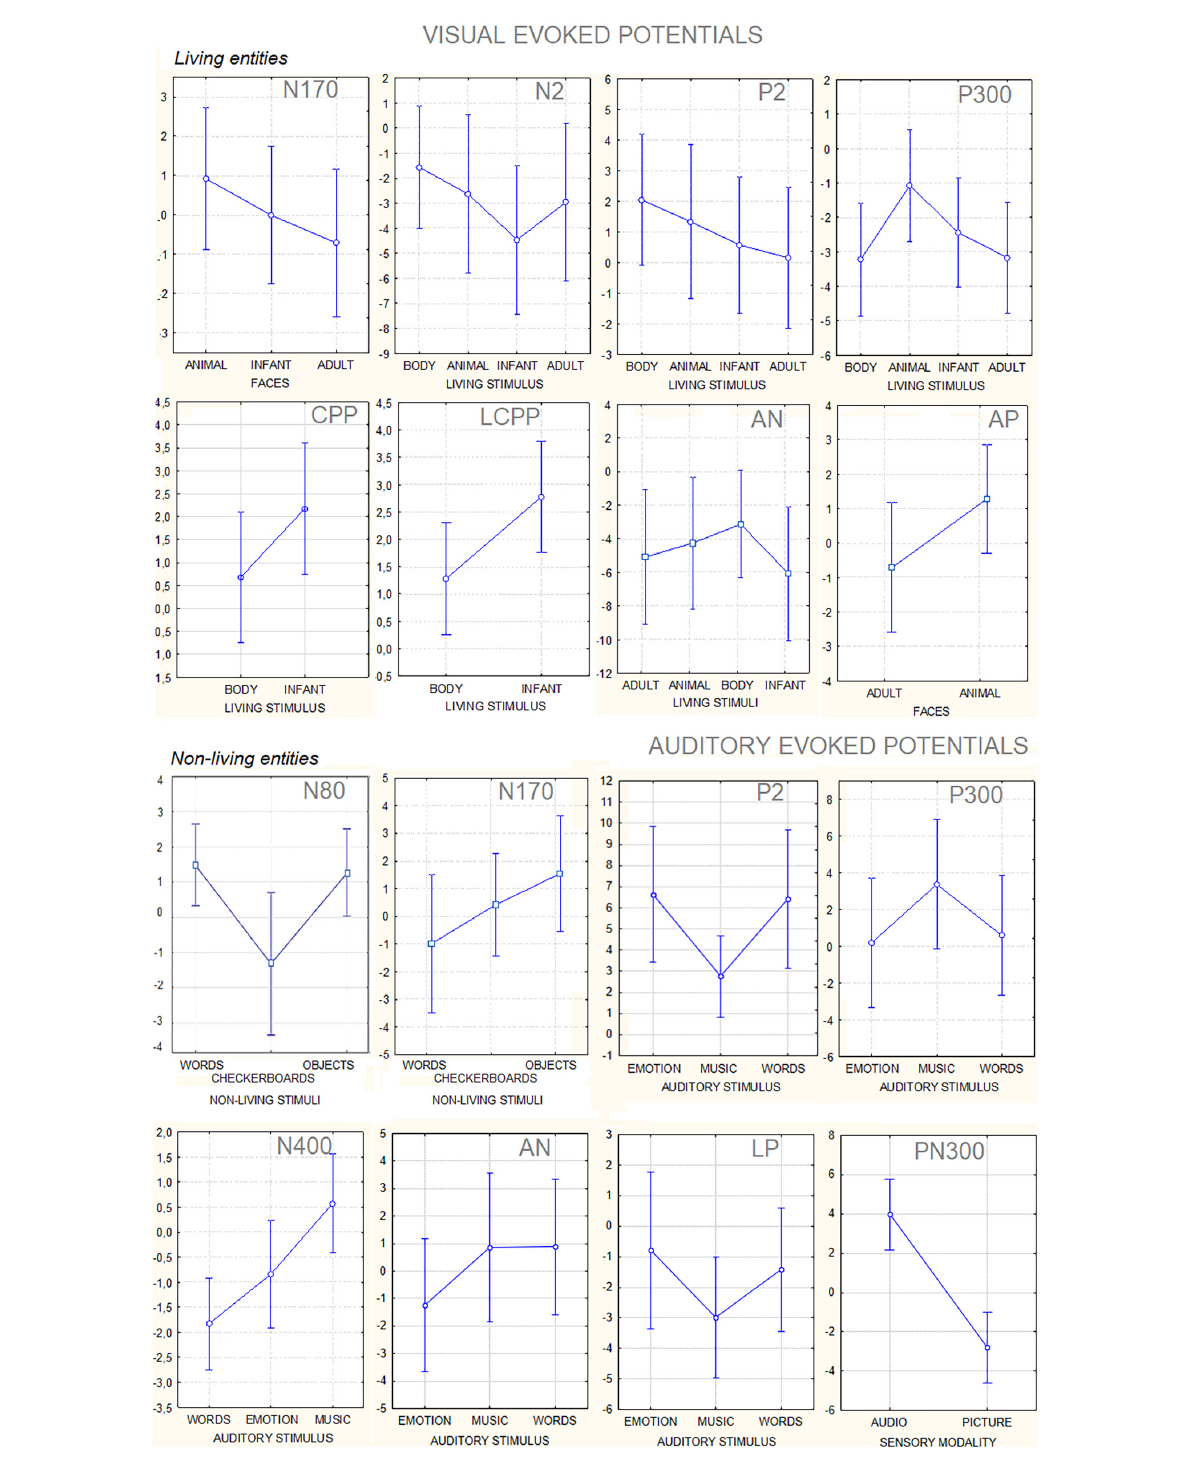
FIGURE8 Mean amplitude values (along with standard deviations) in microvolts of the different component ERPS recorded to visual and auditory stimuli. The data are relative to the grand average computed on the whole group of